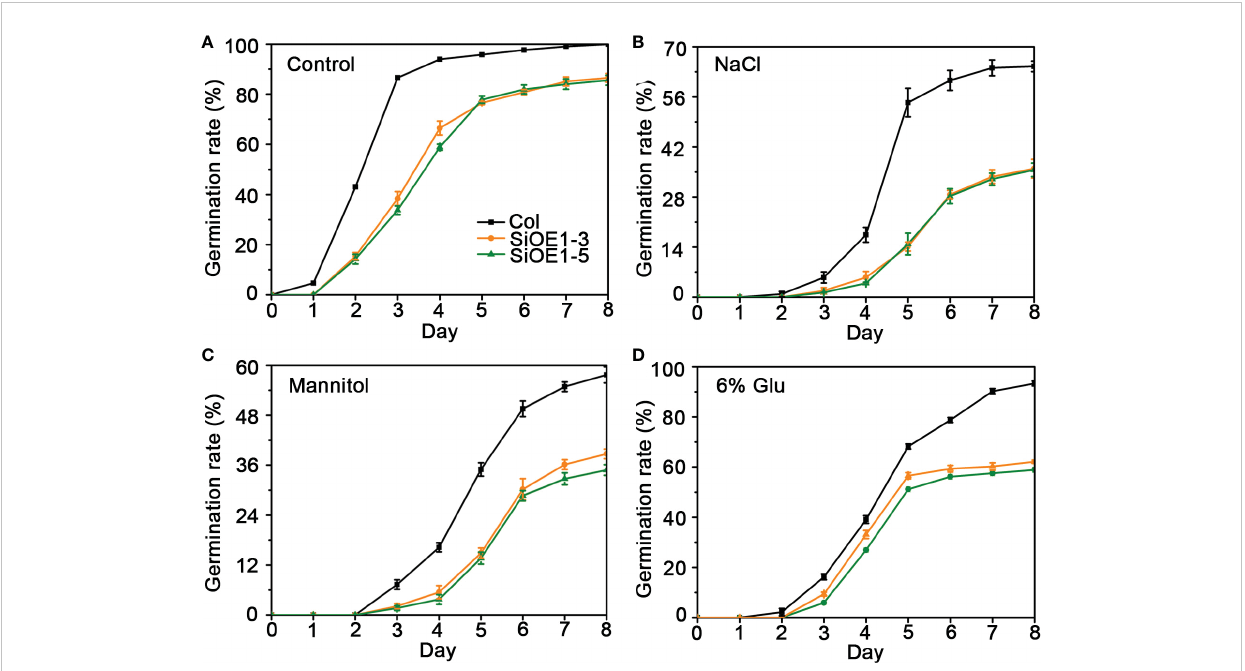
FIGURE 7 Germination rate of Col and SiNCED1 transgenic seeds grown in MS, Mannitol, NaCl and Glucose media. (A – D) The germination rate of Col and SiNCED1 transgenic seeds grown in MS media contain 150 mM NaCl, 275 mM Mannitol, or 6% Glucose. Data shown are mean ± SD from three independent